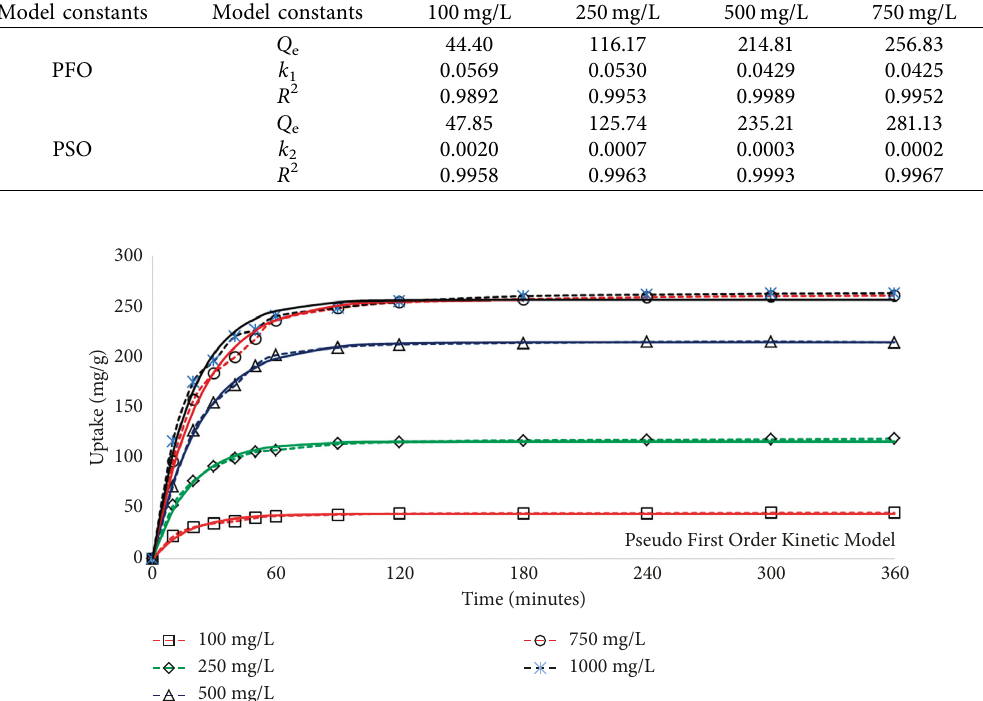
Figure 5: Observations on the elimination of RO16 using the PFO kinetic